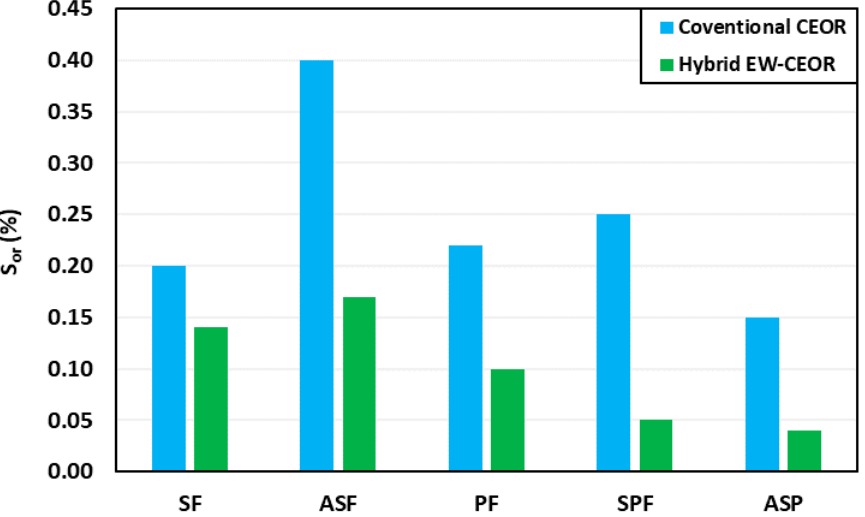
Figure 8. Effectiveness of hybrid EW/CEOR methods in reducing S or compared to conventional CEOR methods.